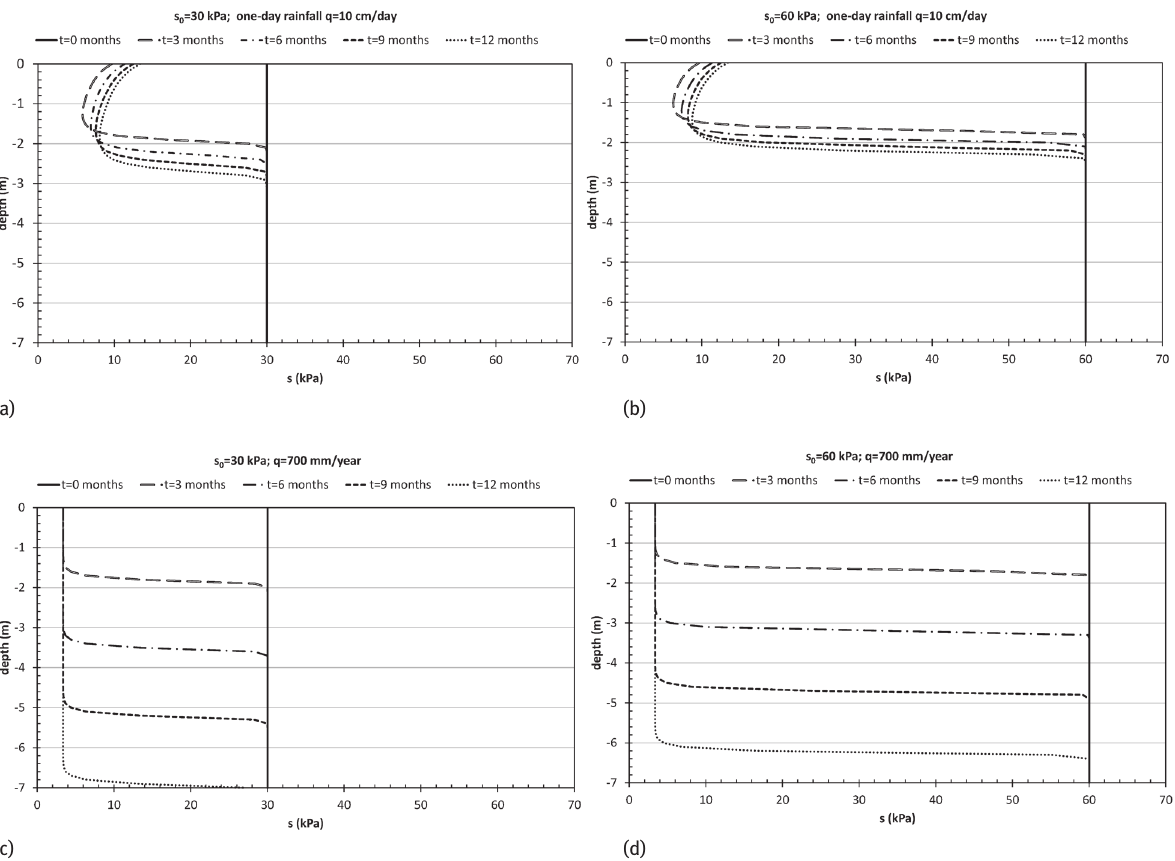
Figure 12: Predicted infiltration due to: (a) an extreme rainfall event through an initially wet stockpile; (b) an extreme rainfall event through an initially dry stockpile; (c) a constant rainfall through an initially wet stockpile; (d) a constant rainfall through an initially dry